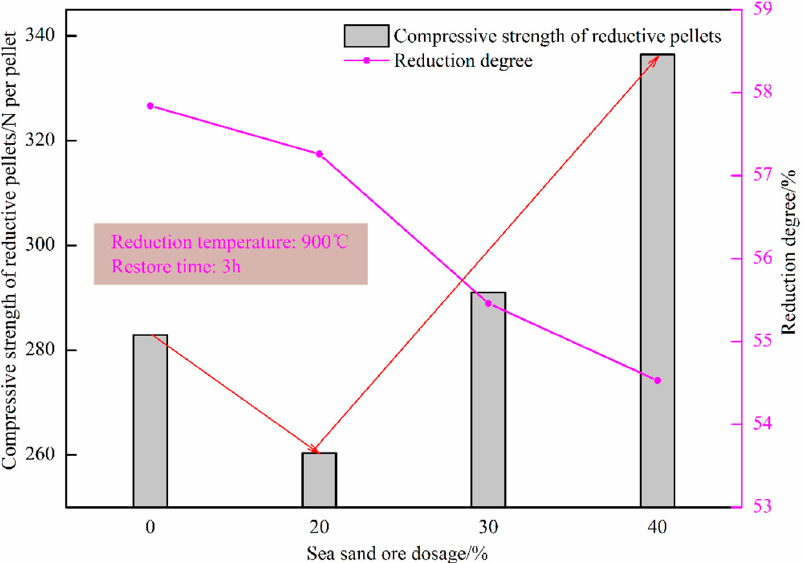
Figure 12. Effect of sea sand ore dosage on the reduction degree of oxidized pellets and compressive strength of reductive pellets. Minerals 2021 , 11 , x FOR PEER REVIEW